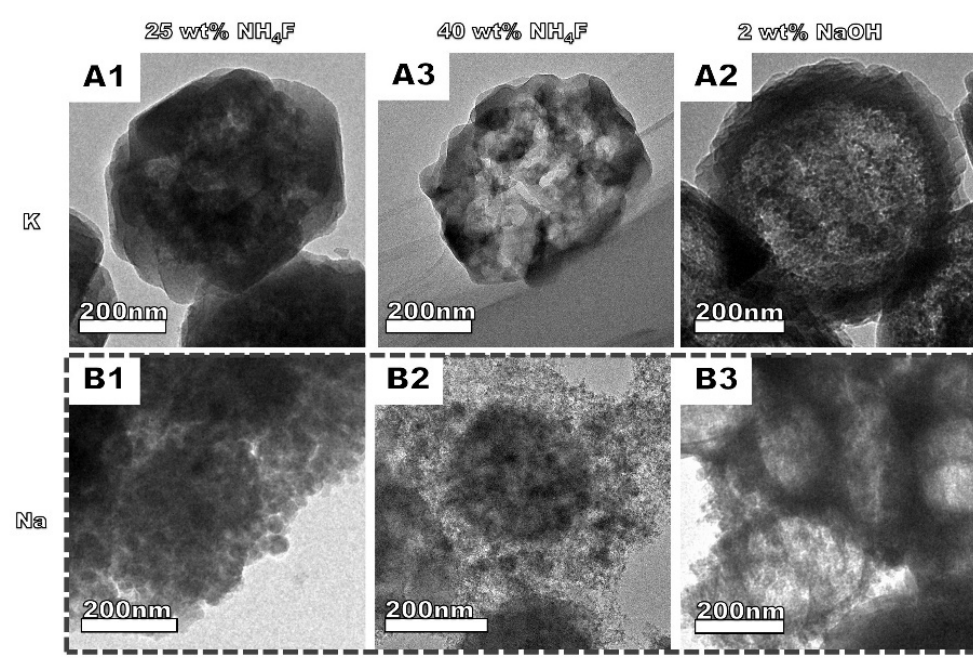
Figure 3. The TEM images of K-Z5-0.15-25-140 products etched via ( A1 ) 25 wt% NH 4 F, ( A2 ) 40 wt% NH 4 F, ( A3 ) 2 wt% NaOH solutions; and Na-Z5-0.15-25-140 products etched via ( B1 ) 25 wt% NH 4 F, ( B2 ) 40 wt% NH 4 F, ( B3 ) 2 wt% NaOH solutions.